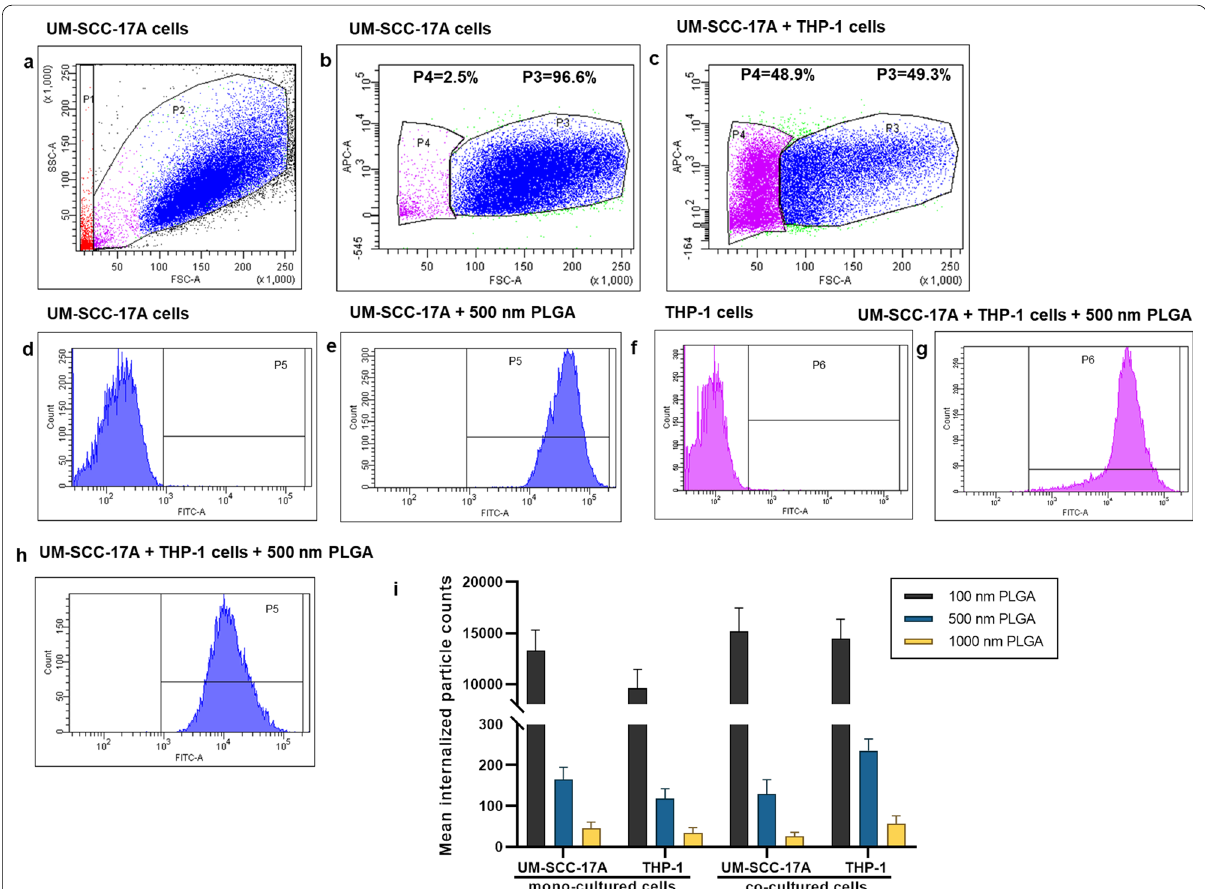
Fig. 8 Particle uptake quantification in monoculture UM‑SCC‑17A cells and co‑culture with THP‑1 cells by flow cytometry. Grating strategy to identify respective cell populations in mixed cell culture ( a – h ). Gating is showing one representative experiment of cells exposure to 500 nm PLGA particles. With initial live gating in the y‑axis with a side scatter (SSC‑A) and x‑axis with a forward scattering (FSC‑A), P2 a were further gated with FSC‑A versus APC‑A to differentiate the THP‑1 cells in P4 c from UM‑SCC‑17A cell population in P3 (monoculture cells ( b ) and mixed cells ( c )). The cell population of P3 further displayed as counts versus FITC plots (P5) in non‑exposed cells ( d ), monoculture cells ( e ), and co‑cultured cells ( h ). Also, P6 is the counts versus FITC‑A plot originated from P4 population in non‑exposed cells ( g ) and co‑cultured cells ( f ). Both types of cells efficiently ingested the 500 nm PLGA indicated by the solid histogram completed shifted to the right side of the x ‑axis, indicating particles are taken up by all exposed cells. Quantification of particle‑laden numbers ( i ) in both types of cells for mono‑culture and co‑culture